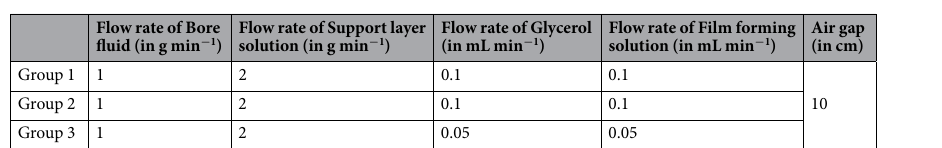
Table 2. Spinning parameters for the experiments of Group 1, 2, and 3 from Table